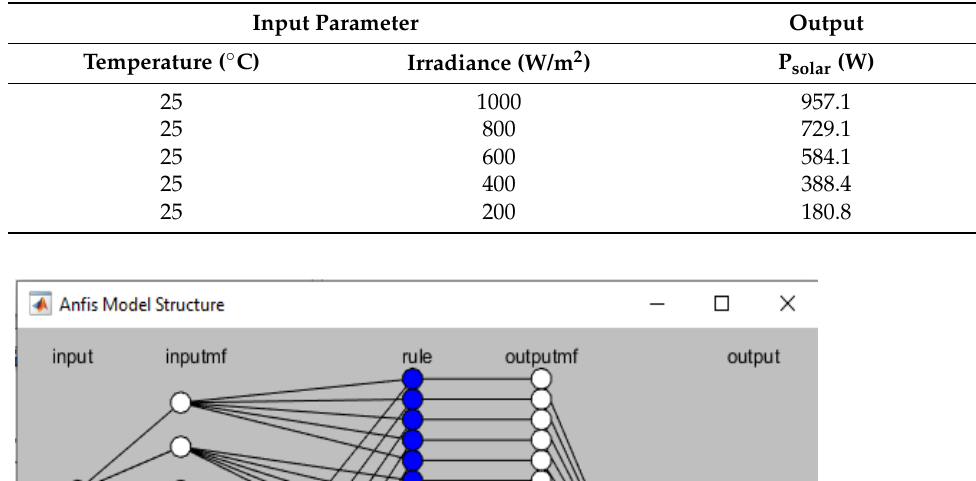
Table 2. P solar simulation results (OSSC size of 9.75 m 2 ).